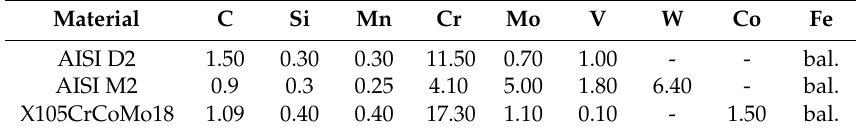
Table 1. Nominal chemical composition of steels used in the investigation (wt